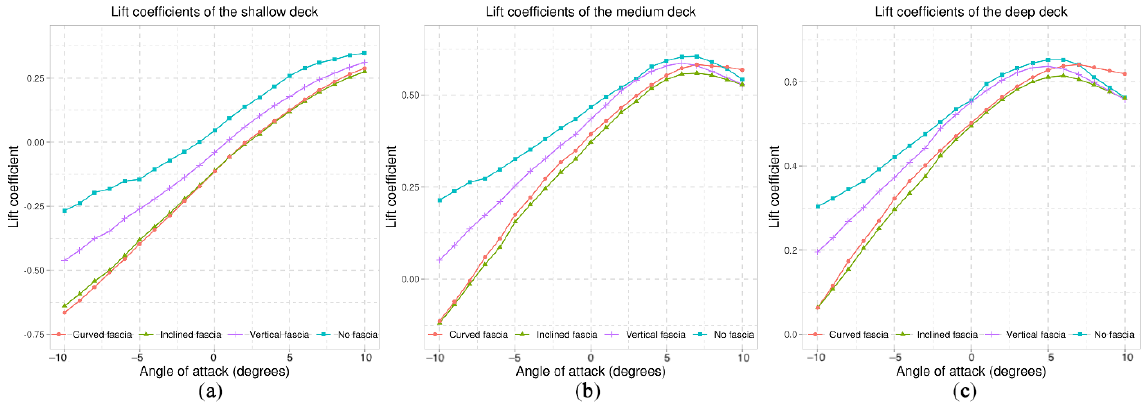
Figure 24. Change in drag coefficient for each fascia beam for the ( a ) shallow deck, ( b ) medium deck, and ( c ) deep deck.